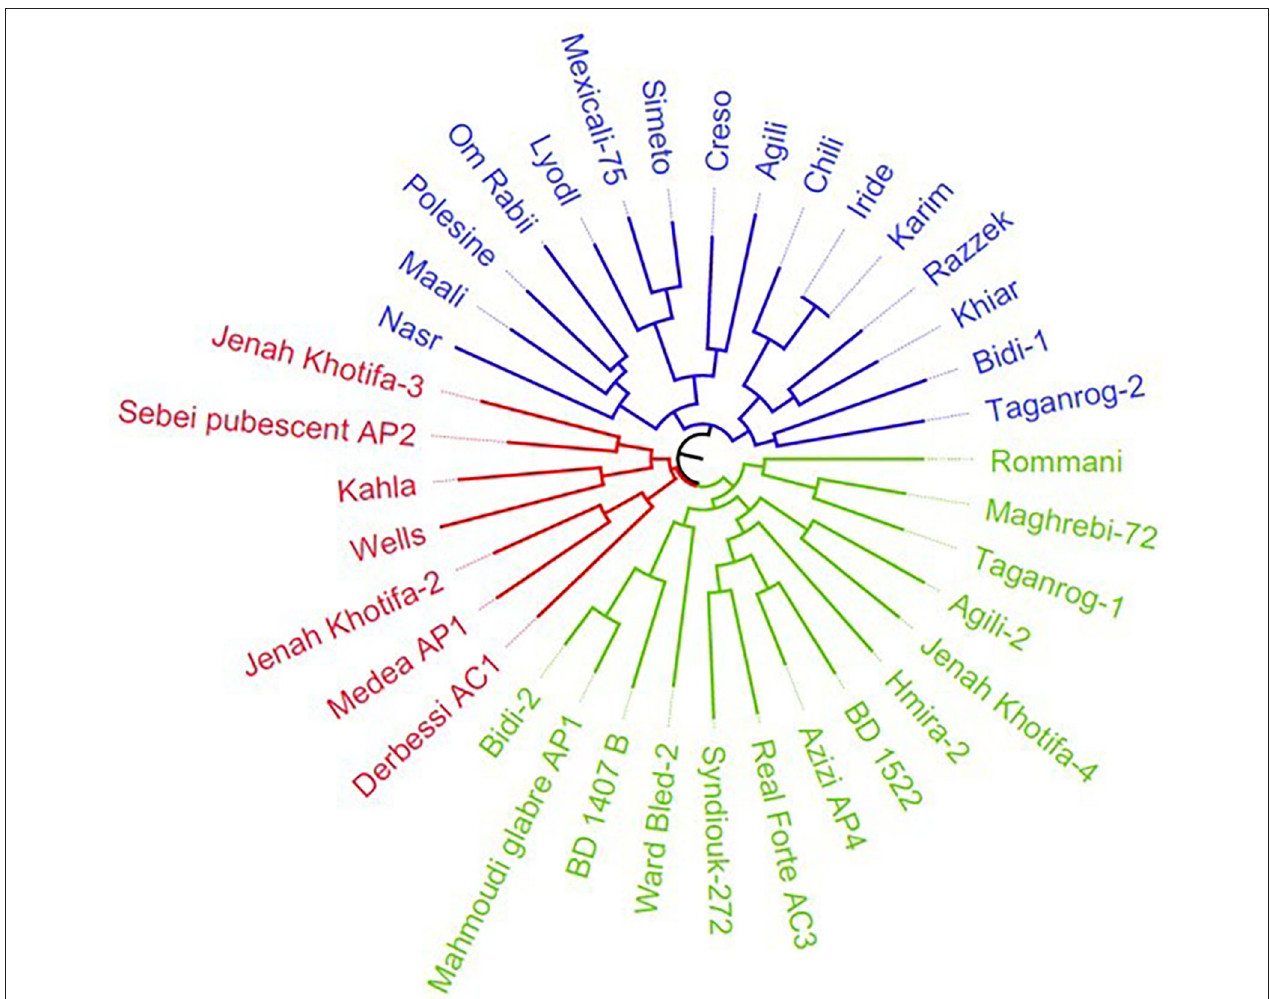
FIGURE 1 | Neighbor-joining dendrogram of durum collection based on nine morphological descriptors. The Tunisian and international durum cultivars are colored in blue, while the Tunisian durum landraces group is indicated in red and green, respectively. The tree excluded the accessions identified as synonymous (Abdelkader,